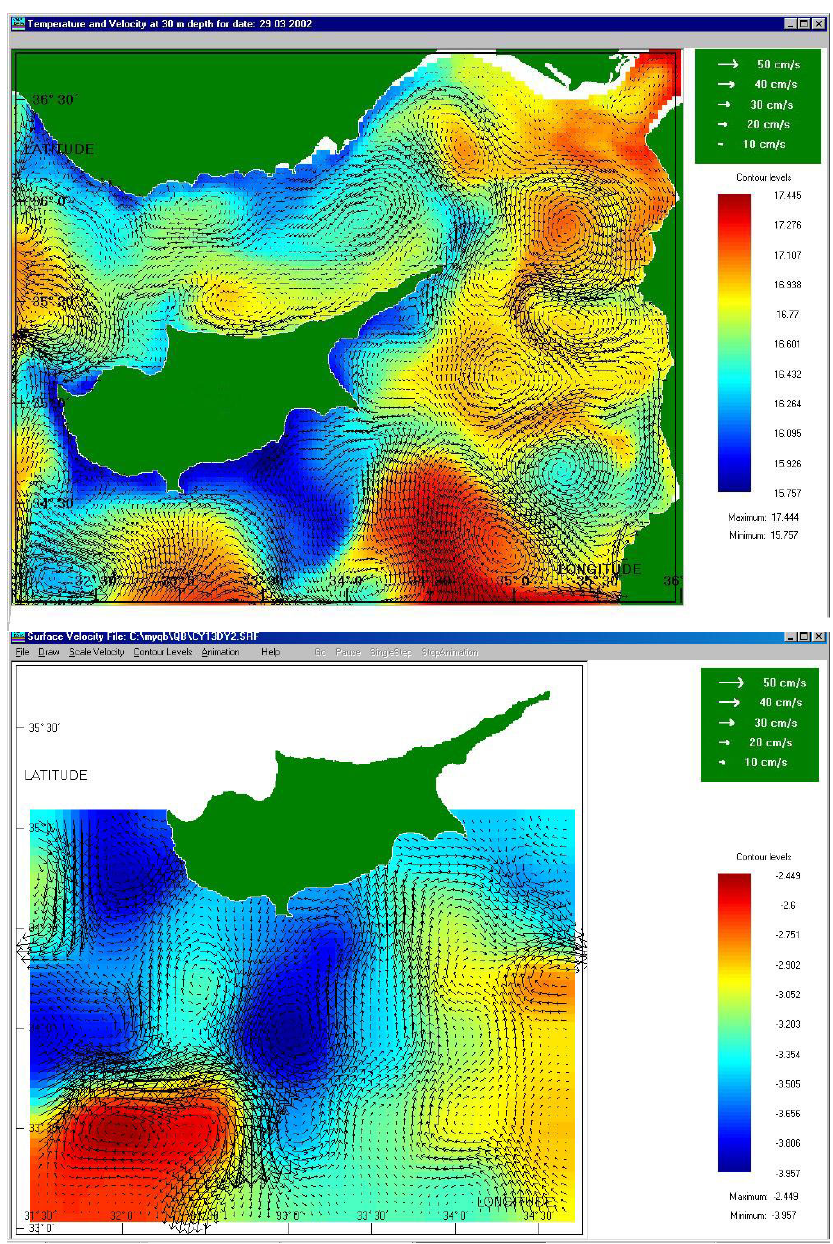
Fig. 10. Comparison of the circu- lation in the SE Levantine Basin at the 30m depth, between: (a) the CYCOM NRT operational forecasts (currents + temperature at the 30m) for 29 March 2002 and (b) the geostrophic flow (geostrophic currents + dynamic height) derived from the CYBO project during March